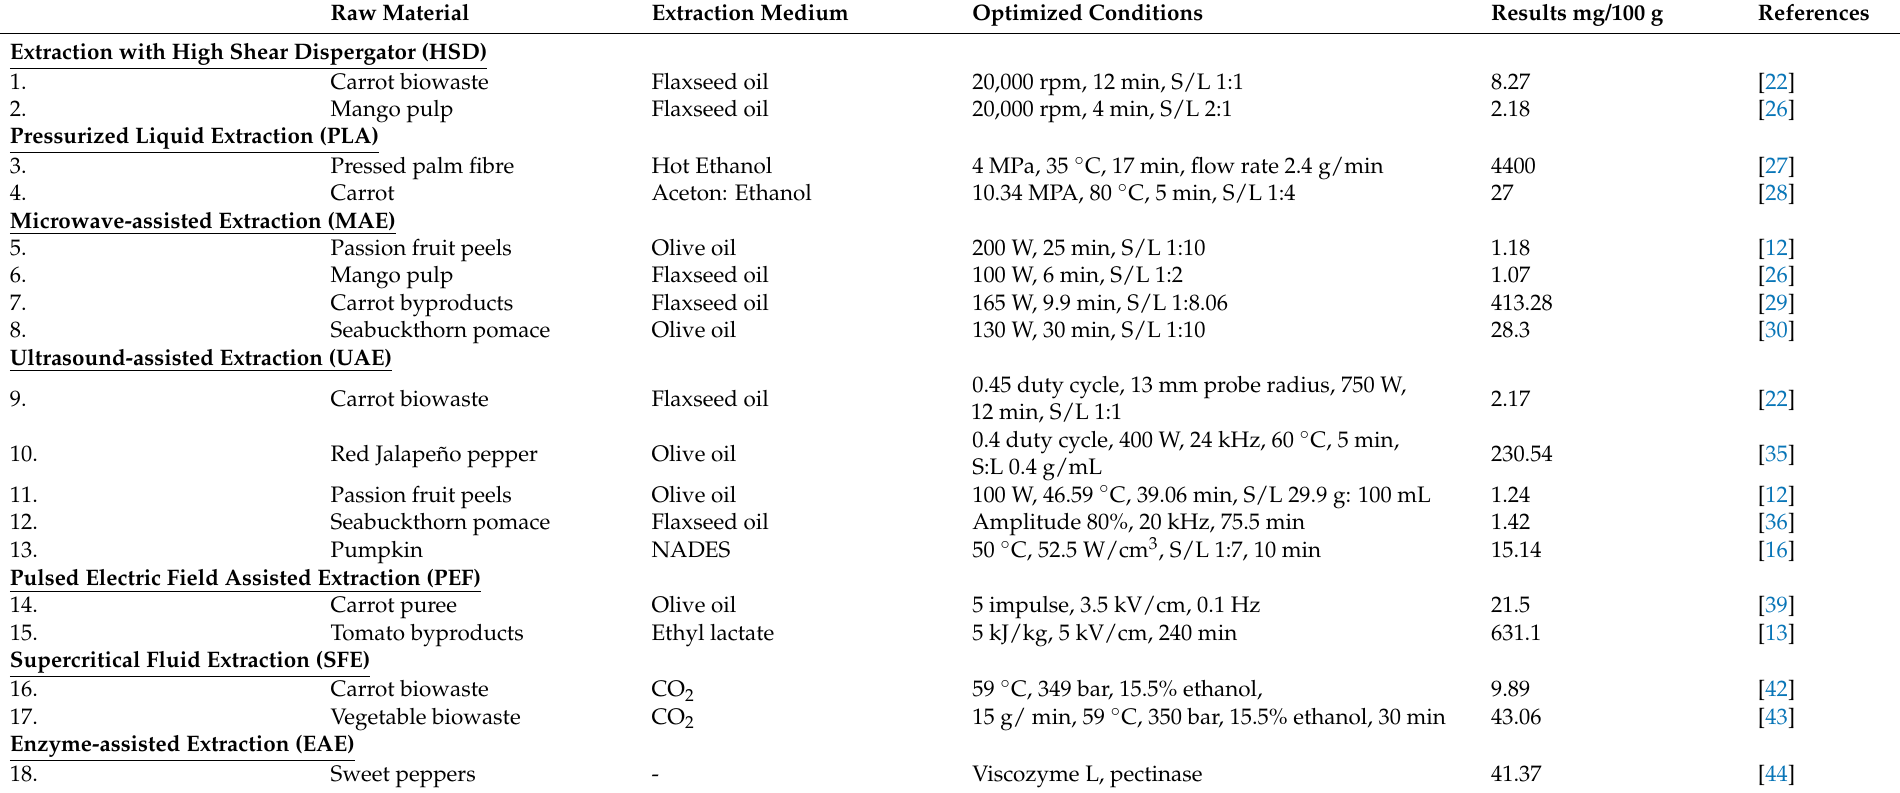
Table 1. Summary of extraction